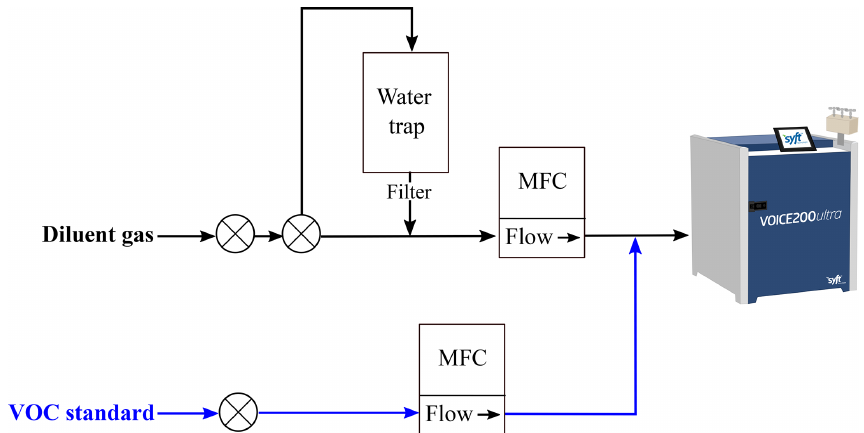
Figure 3. Schematic of the internal gas flow paths in the automated gas calibration unit